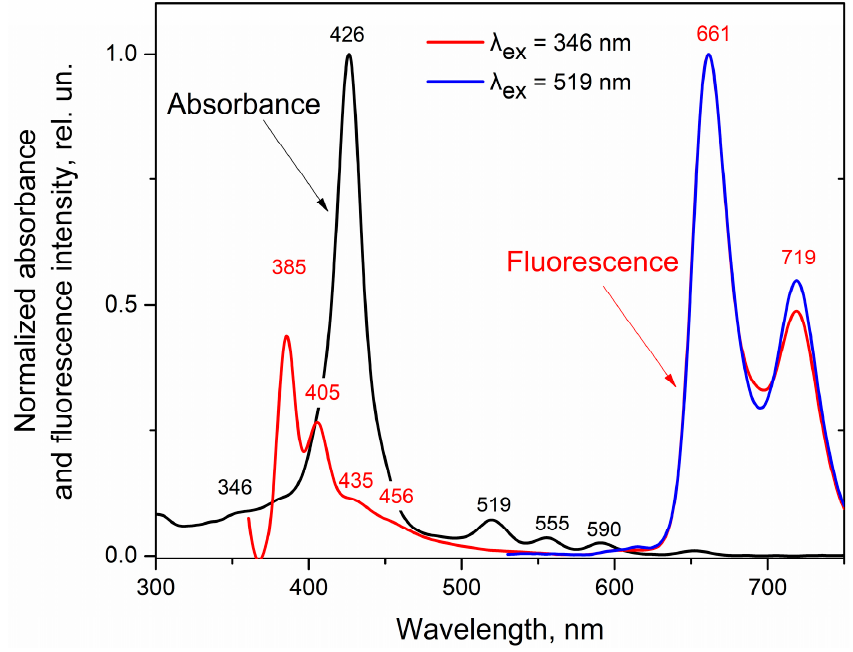
Figure 1. The normalized by maximum UV-vis absorbance and fluorescence spectra of H 2 PIP in toluene. Both H 2 PIP and ZnPIP show dual emission from both pyrene and porphyrin units (red and blue curves in Figures 1 and 2). The direct excitation of porphyrin moiety of H 2 PIP (the blue curve in Figure 1) leads to its emission bands at 661 and 719 nm. The fluorescence spectrum of H 2 PIP upon 346 nm excitation (the red curve in Figure 1) shows the pyrenyl bands at 385 and 405 nm together with less pronounced shoulders at 435 and 456 nm as well as bands at 661 and 719 nm belonging to the porphyrin emission. The spectral overlap between the mentioned region of pyrene emission and Soret band absorbance could be the reason for NRET between the pyrene and porphyrin fragments and, subsequently, such porphyrin fluorescence. Therefore, further in the text we use the letters D (for energy donor) and A (for energy a cceptor) to refer to the pyrene and porphyrin moieties of the dyads, respectively. Such distinction makes the description of photophysical phenomena related to energy transfer easier. At the same time, it should be noted that it is characteristic for porphyrins to have a small intrinsic fluorescence response upon irradiation by light in the near UV-region (see Figure S3 and [72] as an